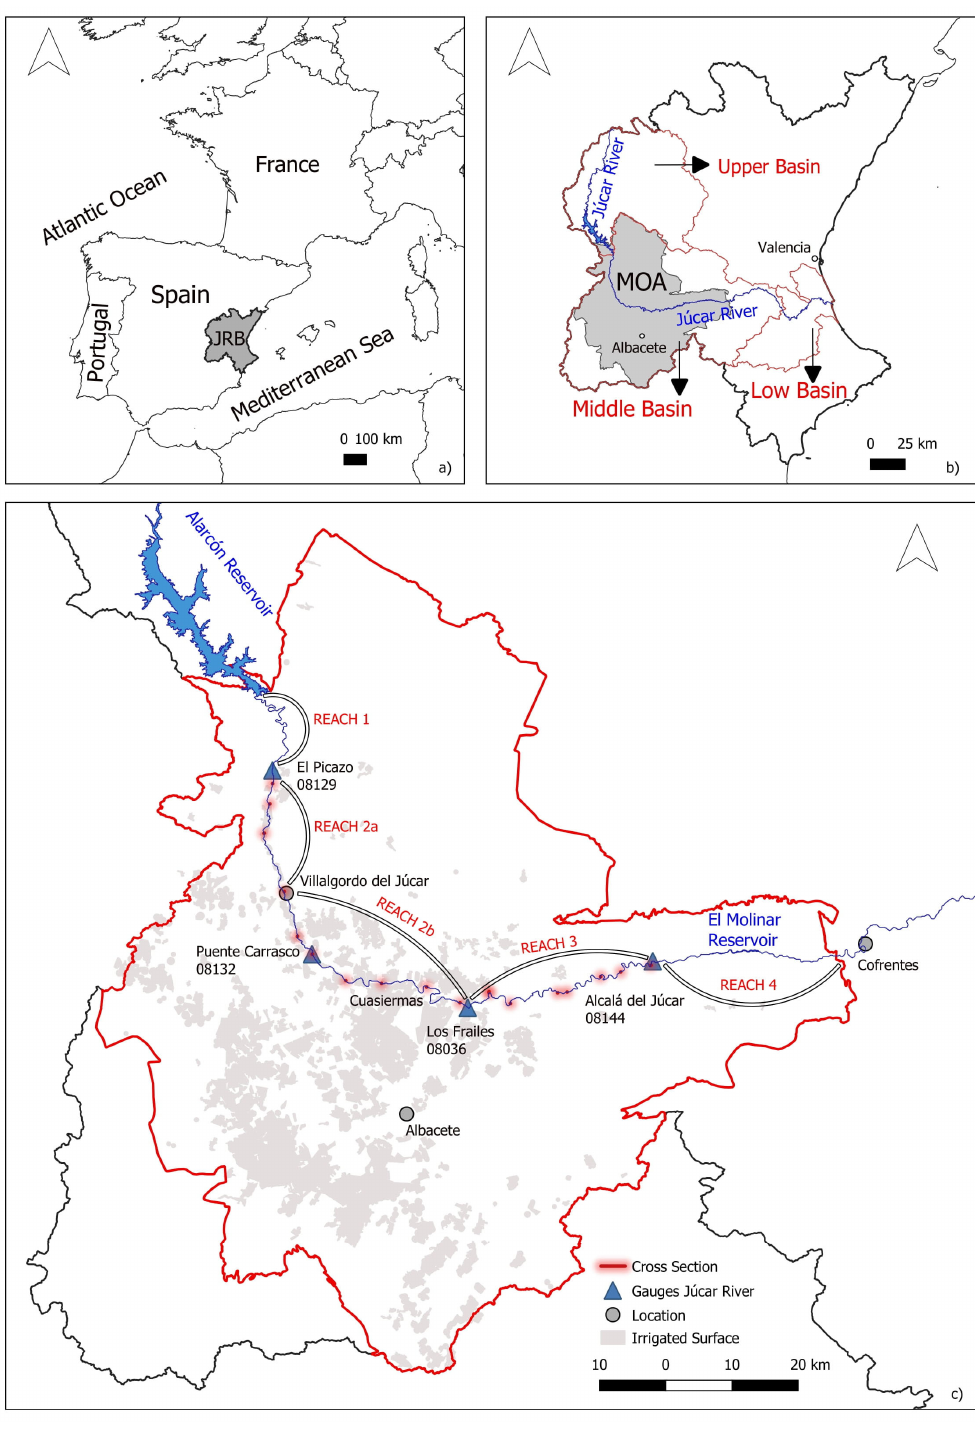
Figure 1. ( a ) Location of the study area. JRB: Júcar River Basin district, ( b ) Júcar River hydrologic unit: The Upper, Middle, and Low sub-basins as defined within the JRB district; MOA: Mancha Oriental Aquifer ( c ) Study area: Reach 1 is from Alarcon Reservoir exit to El Picazo gauge,